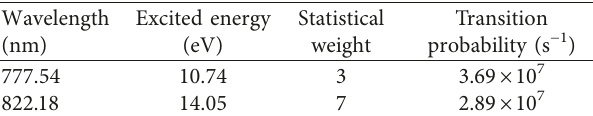
Table 2: Spectral parameters of the SPS of the nitrogen molecule